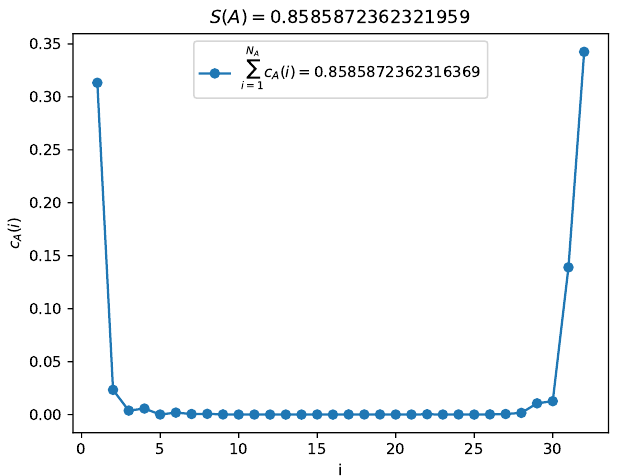
Figure 4: Output of examples 3.11. In the plot it is represented the entanglement contour of the reduced density matrix of the first 32 contiguous site of a linear chain, when the global state is the ground state of a nearest-neighbour Hamiltonian on a linear chain of N = 64 sites. Note how for a nearest neighbour Hamiltonian, the contour is higher on the boundary of the